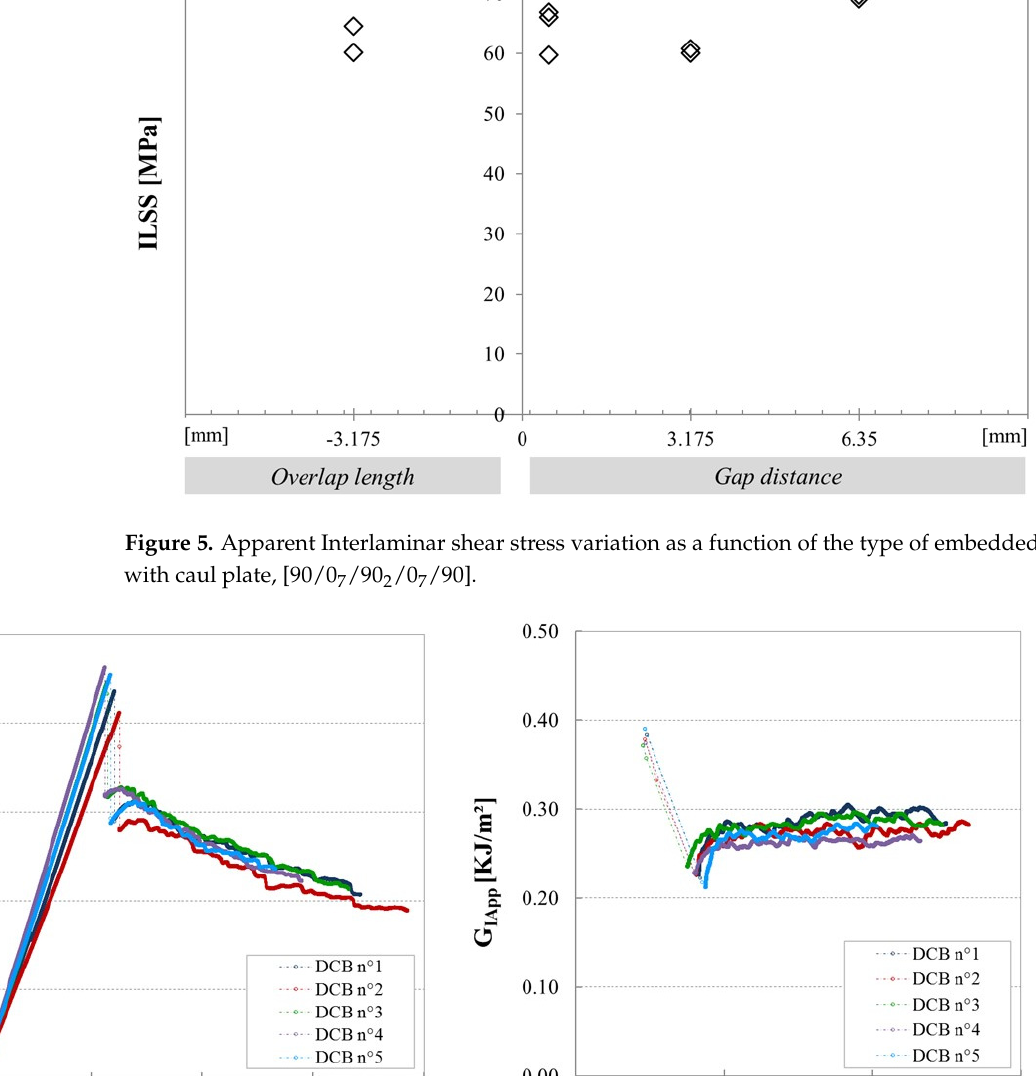
Figure 7. Load vs. displacement traces ( left ) and R-curves ( right ) for cross ply laminates ([90/0 7 /90]s) containing a 0.5 mm gap (considered as reference configuration without defects).